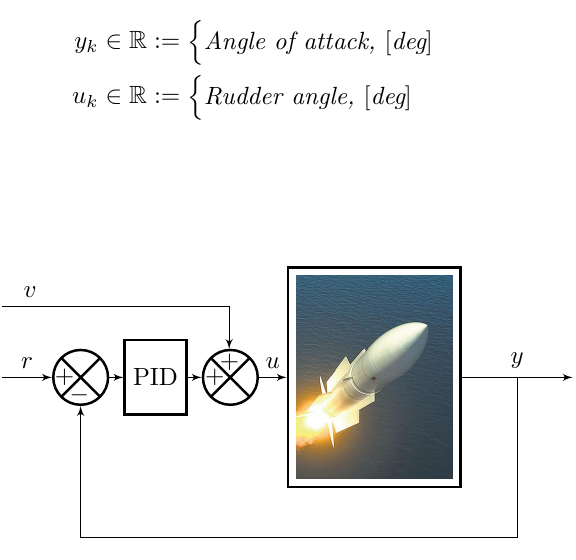
Figure 4: Example 4.2. The figure shows the closed loop system where the process is a nonlin- ear rocket. Output, y := Pitch angle [deg].